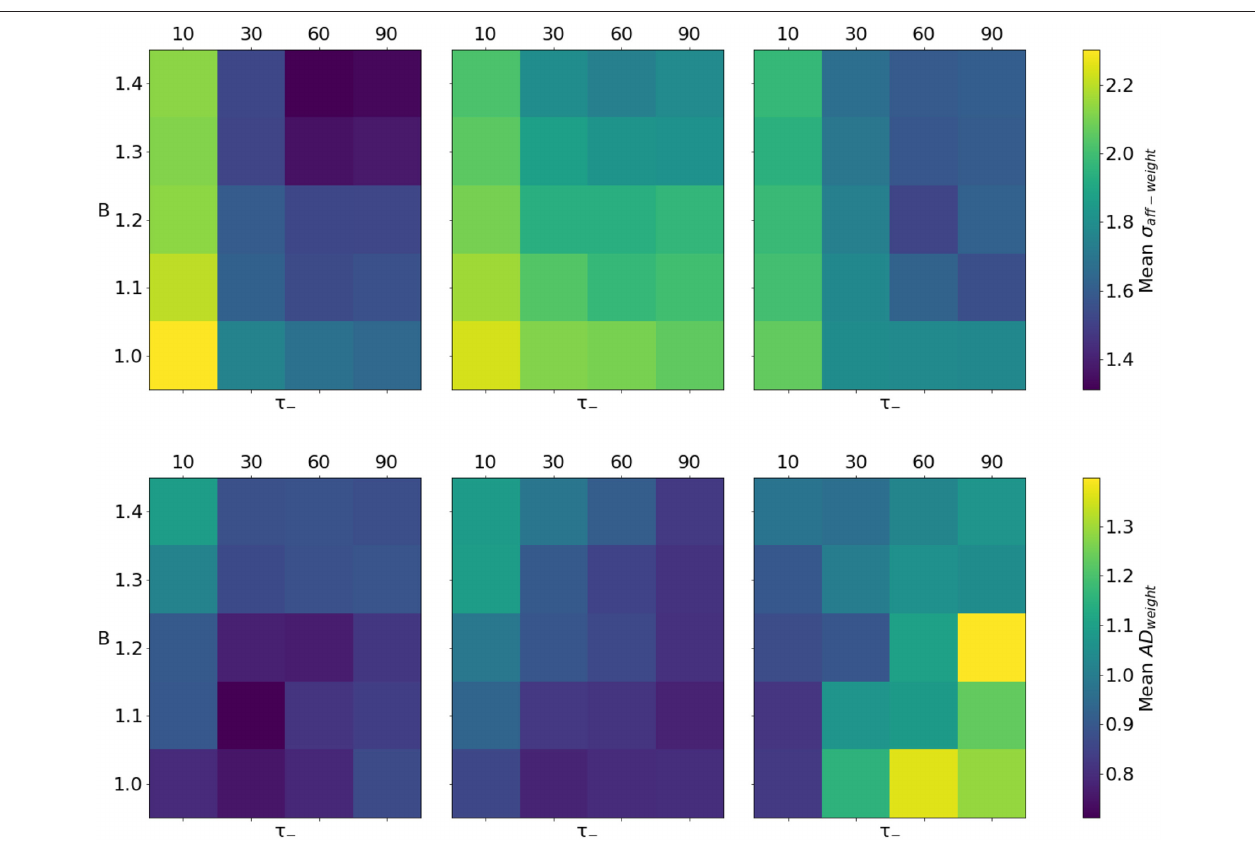
FIGURE 9 | Quality of topographic maps when varying the ratio between inhibition and excitation (B, see Equation 7) and the depression time constant ( τ − ). Lower values are better. Top row : mean spread of the afferent receptive field σ aff − weight . Bottom row : mean weighted Absolute Deviation of the centres of the receptive fields AD weight . Columns represent, from left to right, the 3 considered cases: STDP and synaptic rewiring, or exclusively STDP, both in the presence of input correlations (Case 1 and 2, respectively), and, finally, STDP in conjunction with synaptic rewiring, this time without input correlations (Case